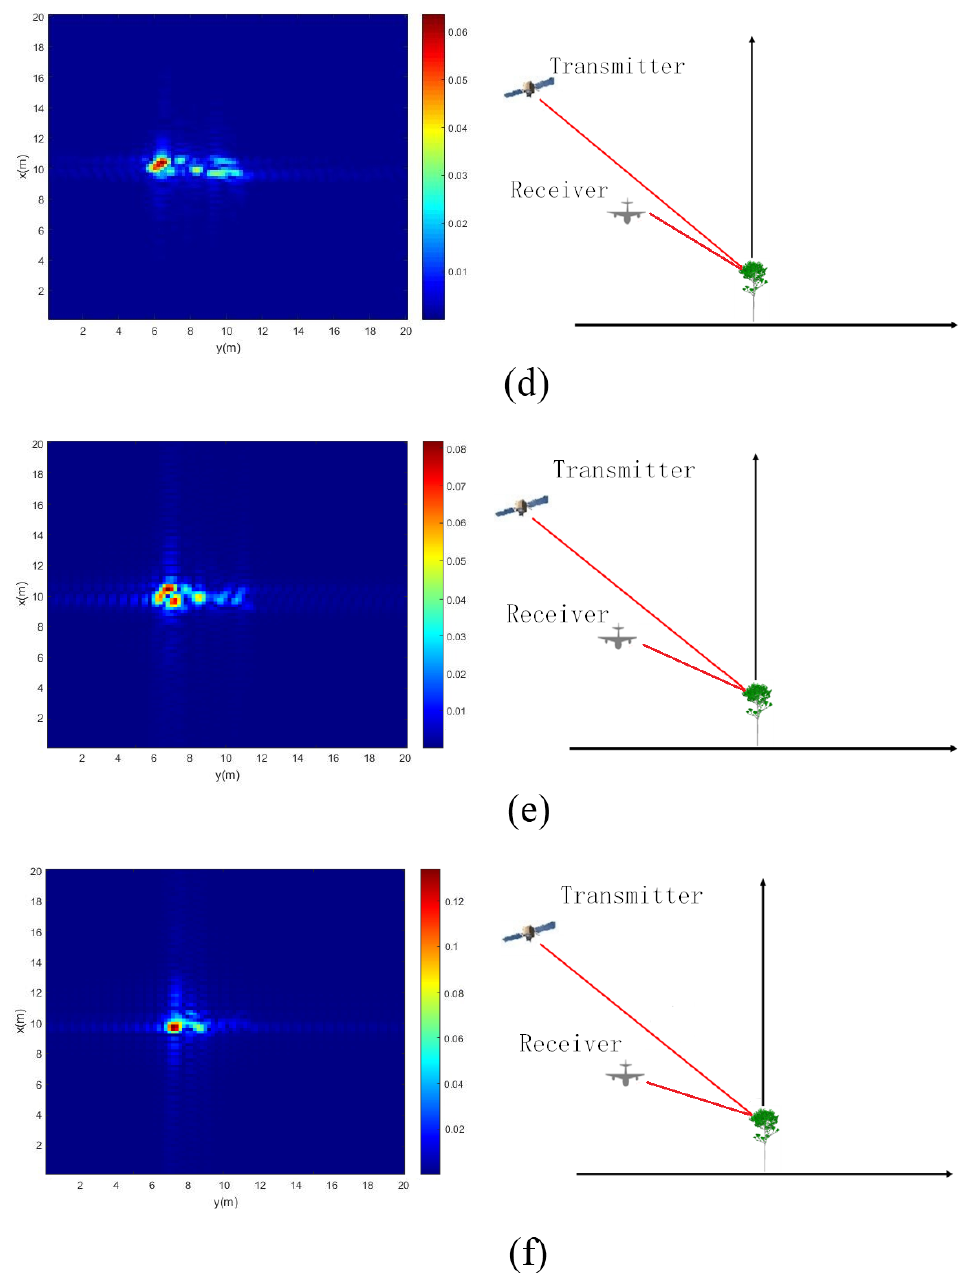
Figure 4. UAV imaging results of a single tree at different receiver zenith angles: ( a ) receiving zenith angle = 26 ◦ ; ( b ) receiving zenith angle = 36 ◦ ; ( c ) receiving zenith angle = 46 ◦ ; ( d ) receiving zenith angle = 56 ◦ ; ( e ) receiving zenith angle = 66 ◦ ; ( f ) receiving zenith angle = 76 ◦